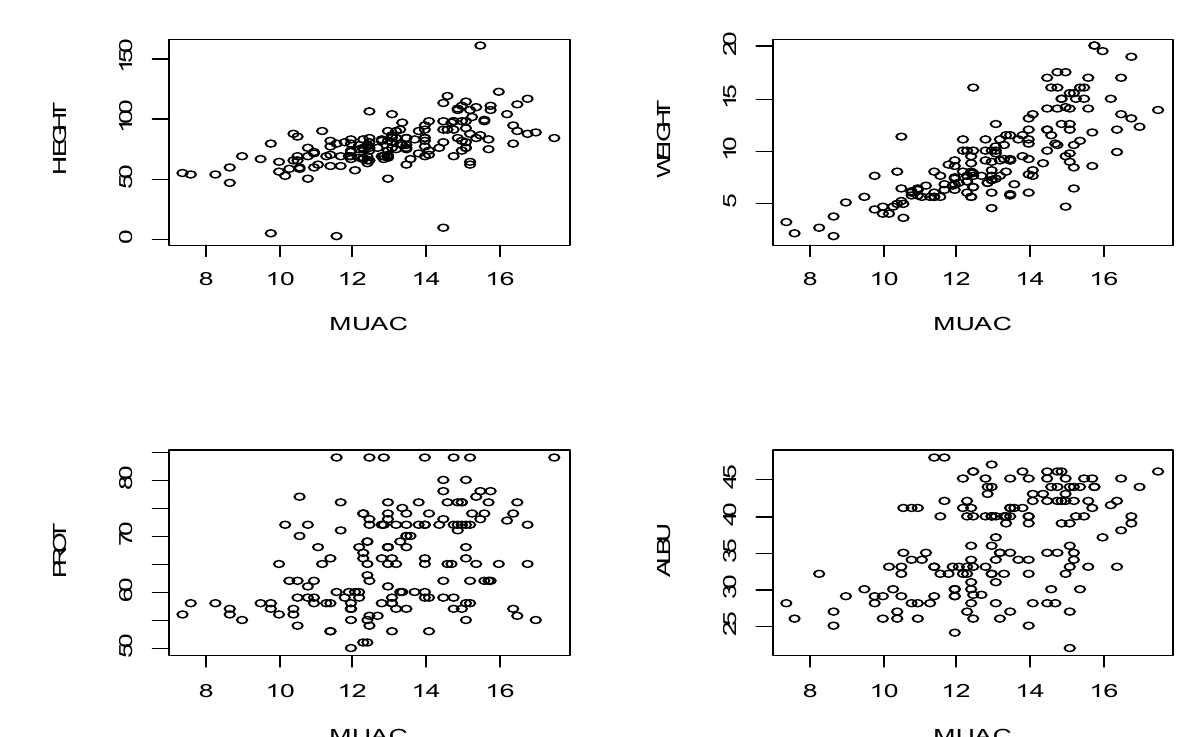
Figure 1. Scatter plots for selected parameters versus Mid Upper Arm Circumference (MUAC).